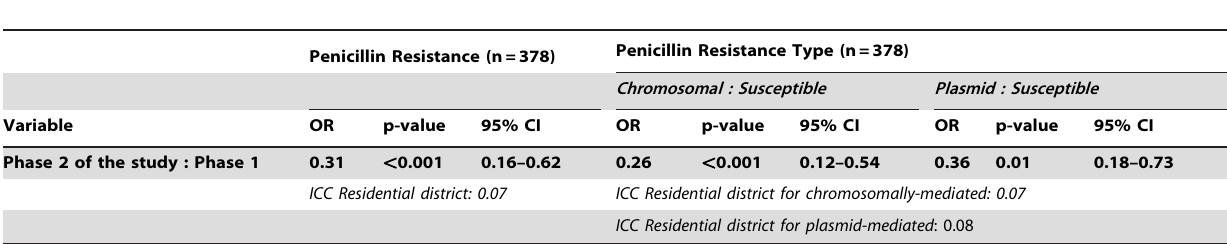
Table 5. Results of multivariable analysis of factors associated with resistance to penicillin based on MIC classification and type